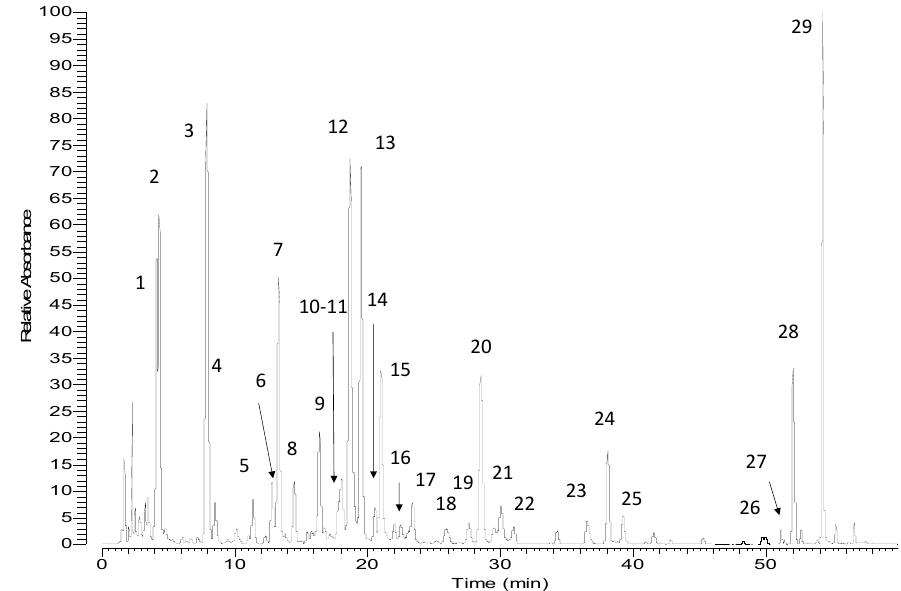
Figure 1. Representative chromatograms of Matricaria recutita flos from Greece. Experimental conditions: column: Zorbax SBAq RP-C18 (150 × 3.0 mm), particle size 5µm (Agilent) at 30 °C. 1 Chlorogenic acid; 2 cis - 2-hydroxy-4-methoxycinnamic-oxo-2- Ο - β -D-glucopyranoside; 3 quercetagenin-3- Ο -glucoside; 4 trans - 2-hydroxy-4-methoxycinnamic-oxo-2- Ο - β -D-glu- copyranoside; 5 quercetin-7- Ο -hexoside; 6 patuletin-7- Ο -glucoside; 7 patuletin-3- Ο -glucoside; 8 luteolin-7- Ο -glucoside; 9